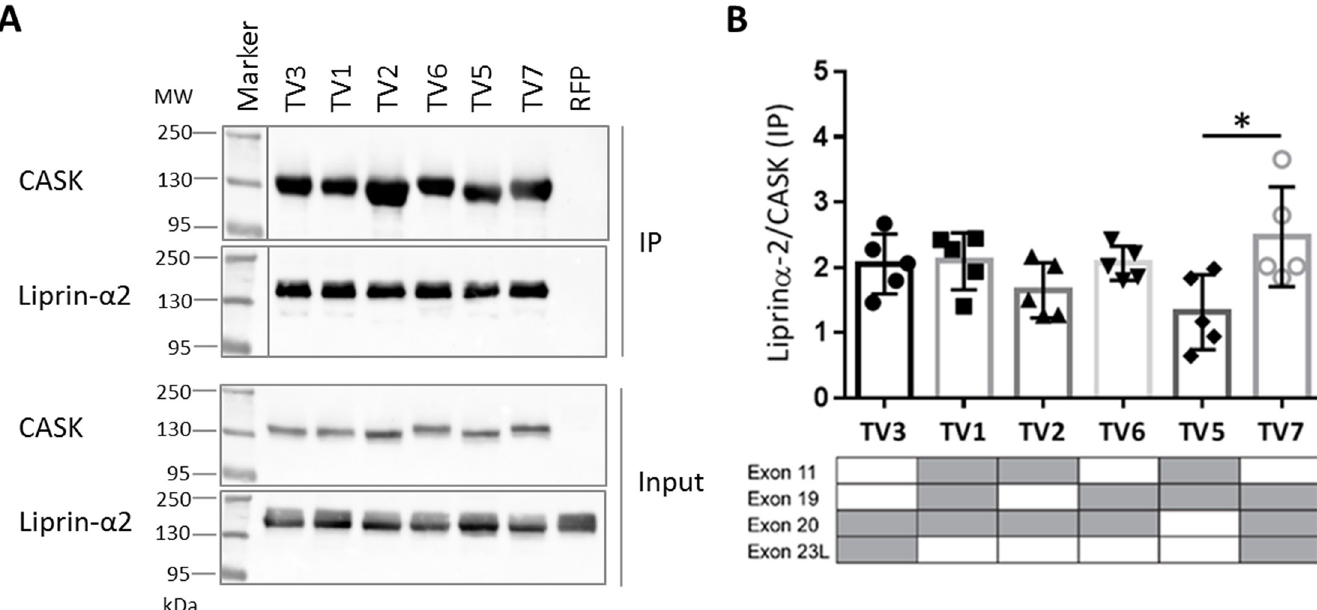
Fig 3. CASK TV5 binds liprin- α 2 weaker than TV7. A: HEK293-T cells were transfected with plasmids encoding for different RFP-tagged CASK variants (TV1-TV7; TV4 not present), as well as HA-liprin- α 2. RFP was used as a negative control. After lysis of the cells in RIPA buffer, RFP-tagged proteins were immunoprecipitated by RFP-Trap. In western blot analysis, CASK and liprin- α 2 were detected in input and immunoprecipitate (IP) sample using α -CASK and α HA antibodies. B: Liprin- α 2 IP signals were normalized against the appropriate CASK IP signal in five independent repeats. The means ± SD are shown. The presence of alternatively spliced exons is indicated by grey colour in tables below the respective bar graphs. � P � 0.05, one-way ANOVA with Tukey’s multiple comparisons test, n = 5.